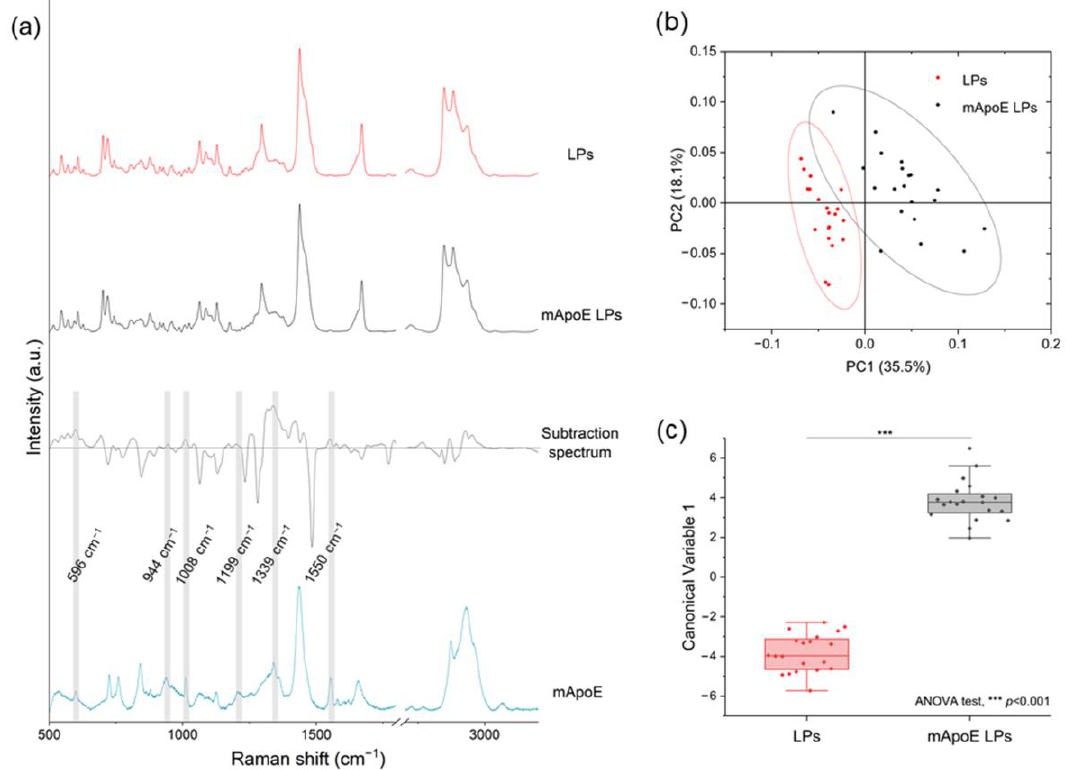
Figure 3. ( a ) LP and mApoE LP spectra, relative subtraction spectrum and mApoE spectrum are represented after baseline subtraction and normalization; ( b ) results of PCA on Raman spectra of LPs and mApoE LPs. Each dot represents one spectrum; ( c ) statistical analysis of the LDA results for the two LPs.